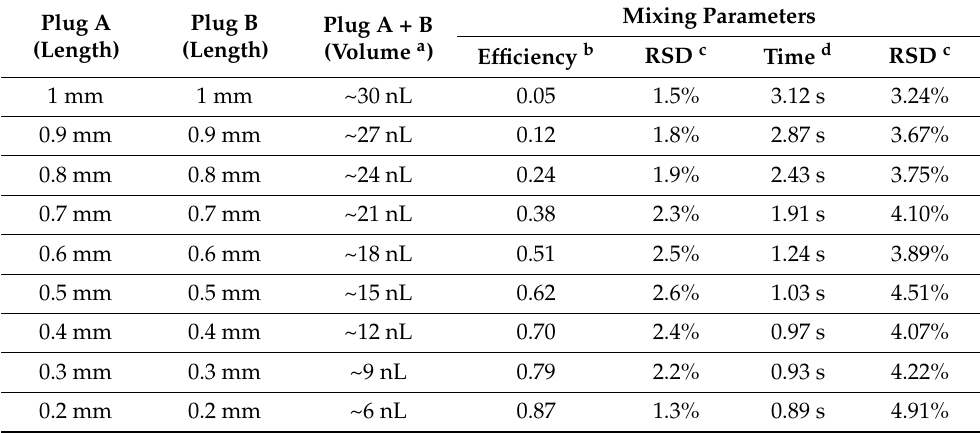
Table 1. The mixing parameters for loading different volumes of